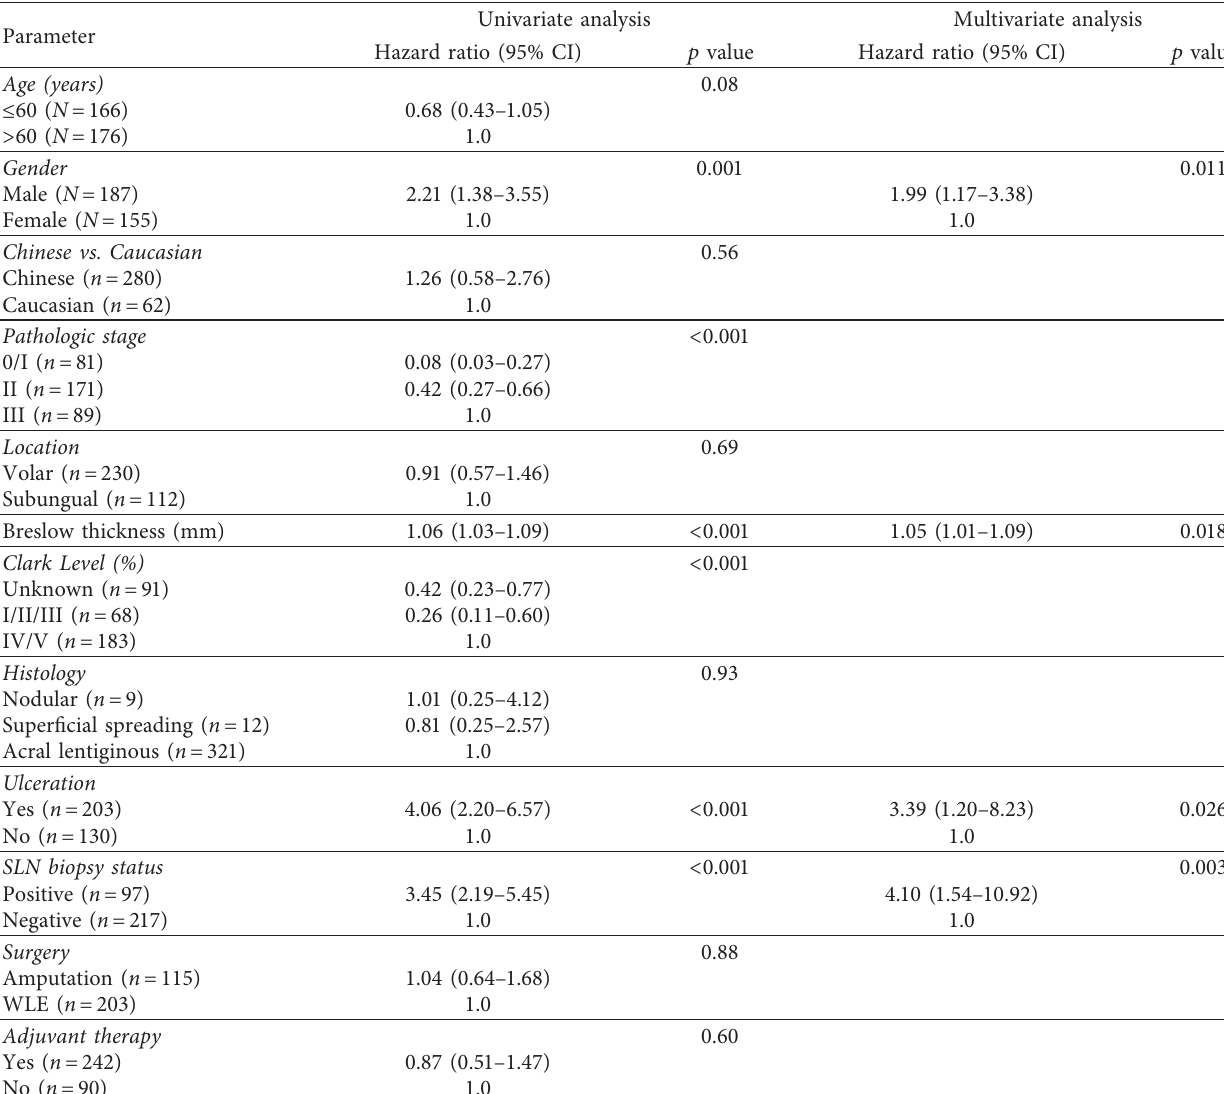
Table 3: Prognostic factors associated with DSS in AM patients.